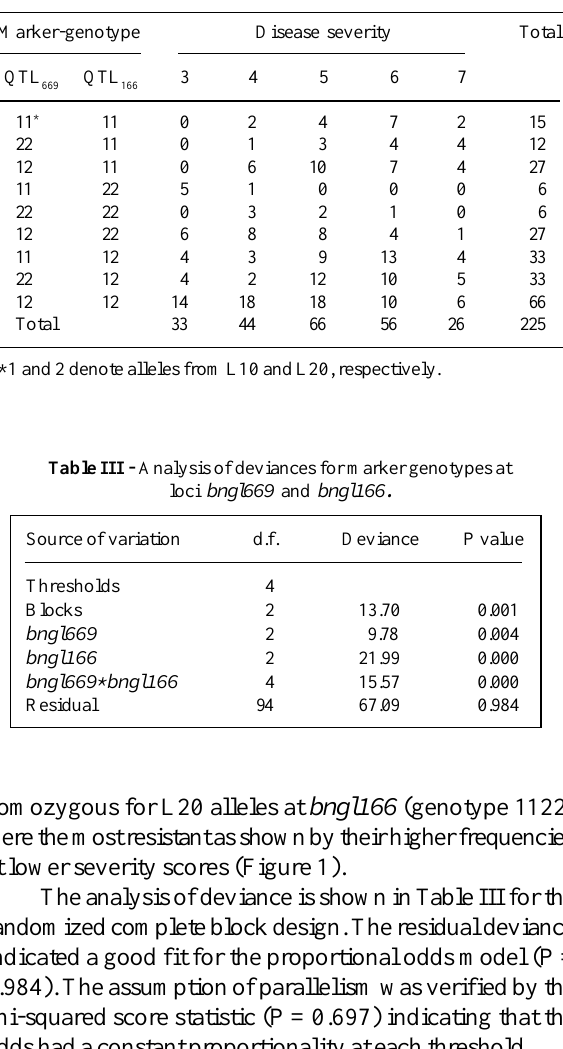
Table II - Observed frequencies of marker genotypes in each cell of the contingency table. Marker-genotype